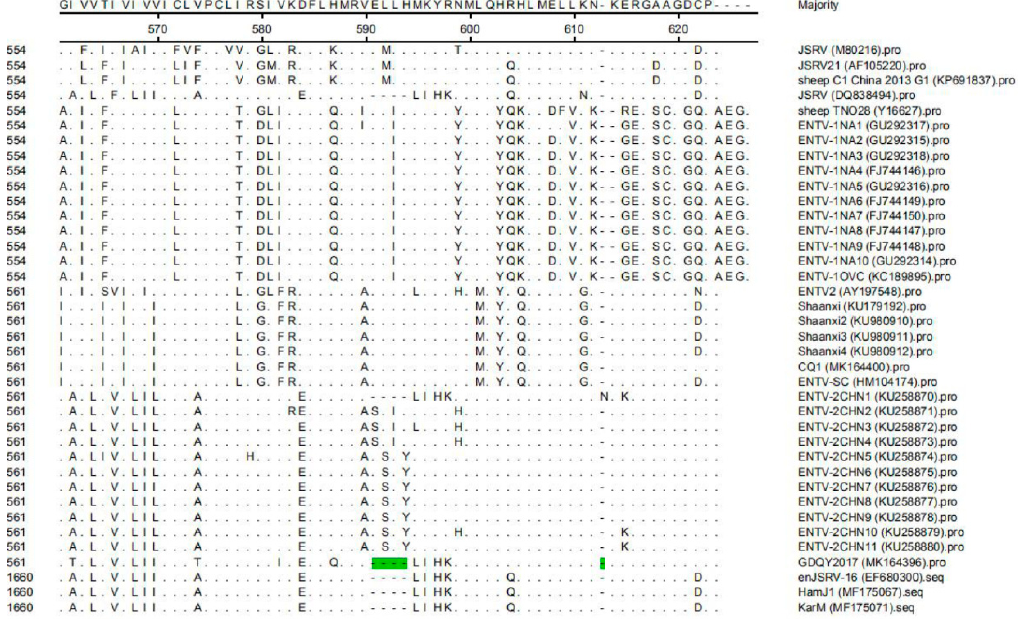
Figure 6. Multiple sequence alignment results of the env protein of ENTV-2 with ENTV-1, JSRV, and enJSRV. The amino acid deletion sites in the env protein of GDQY2017 were marked with green color.